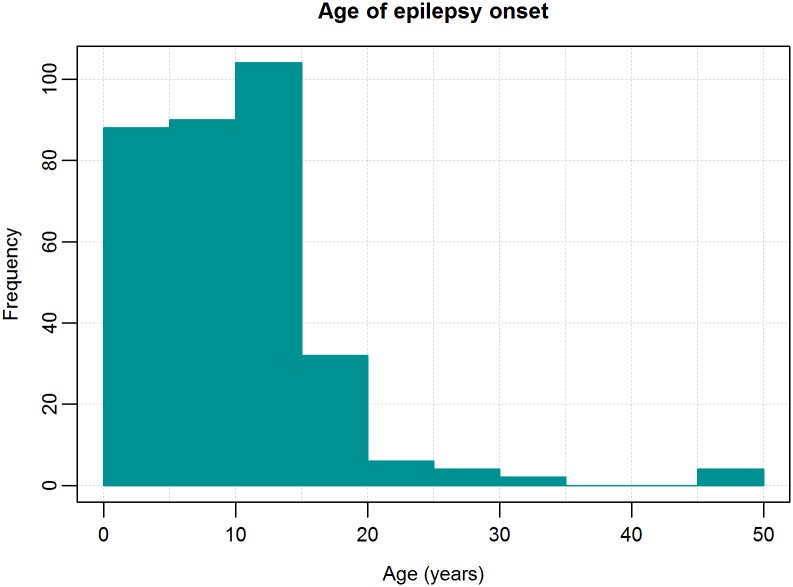
Histogram of age of epilepsy onset.